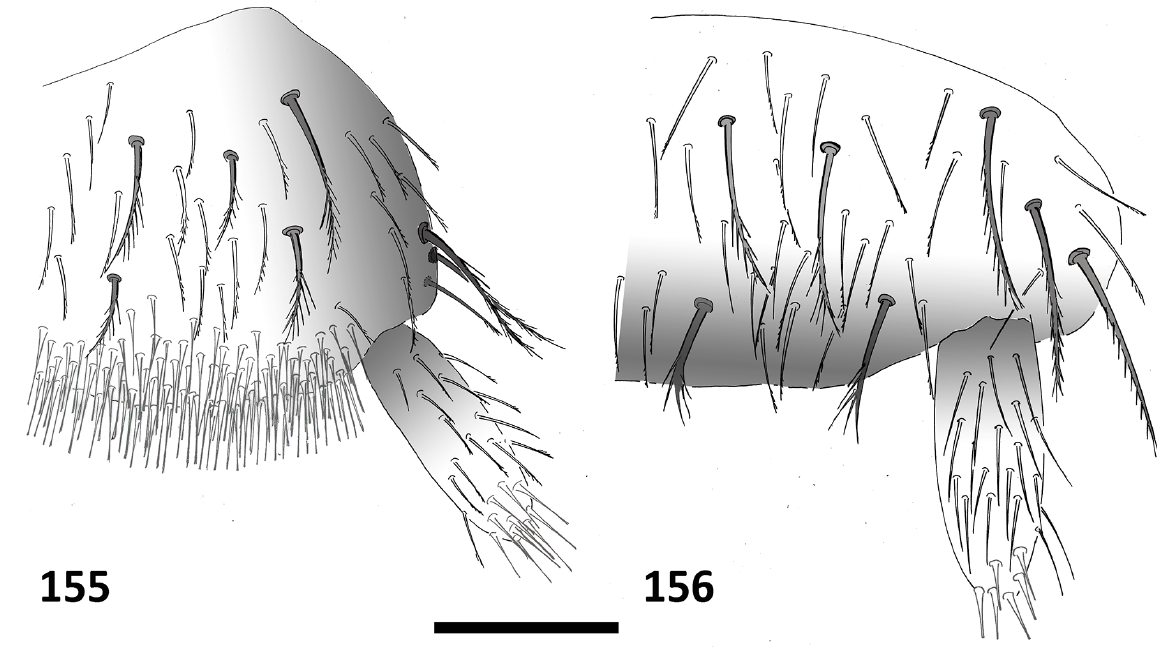
Figs 155–156. Plusiocampa ( Plusiocampa ) ternovensis Sendra & Borko sp. nov. 155 . Paratype, ♂, 4.7 mm long (PMSL Diplura-002); urosternite I, left side. 156 . ♀, 5.3 mm long (Coll. AS); urosternite I, left side. Scale bar: 0.1